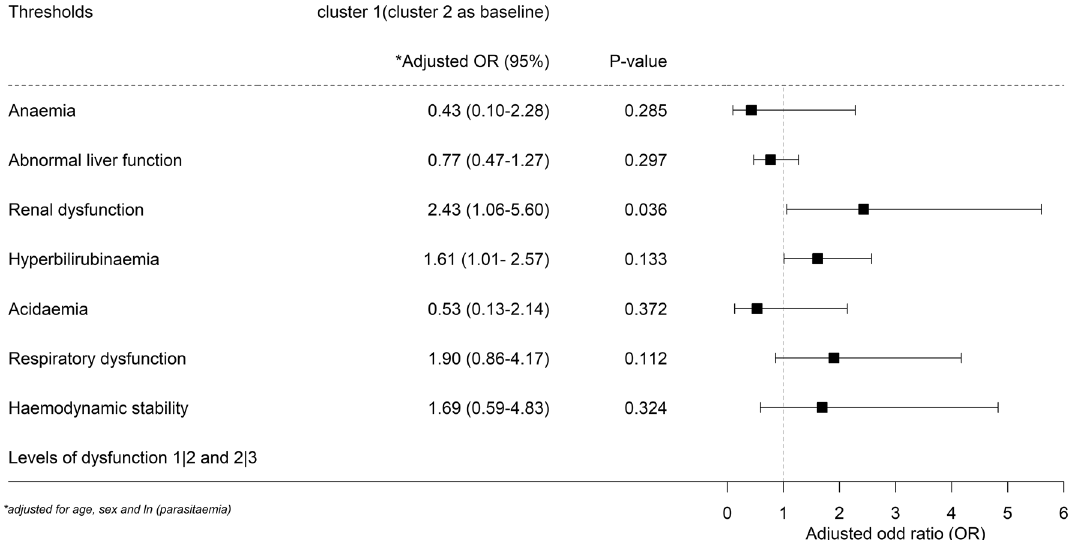
Figure 3. Forest plot with end organ markers as outcome in ordinal logistic regression (cluster 1 = 298, cluster 2 = 115) adjusted for age, sex and ln (parasitaemia) for P. knowlesi infection. Detailed categorisation of variables is summarised in Supplementary Table S7